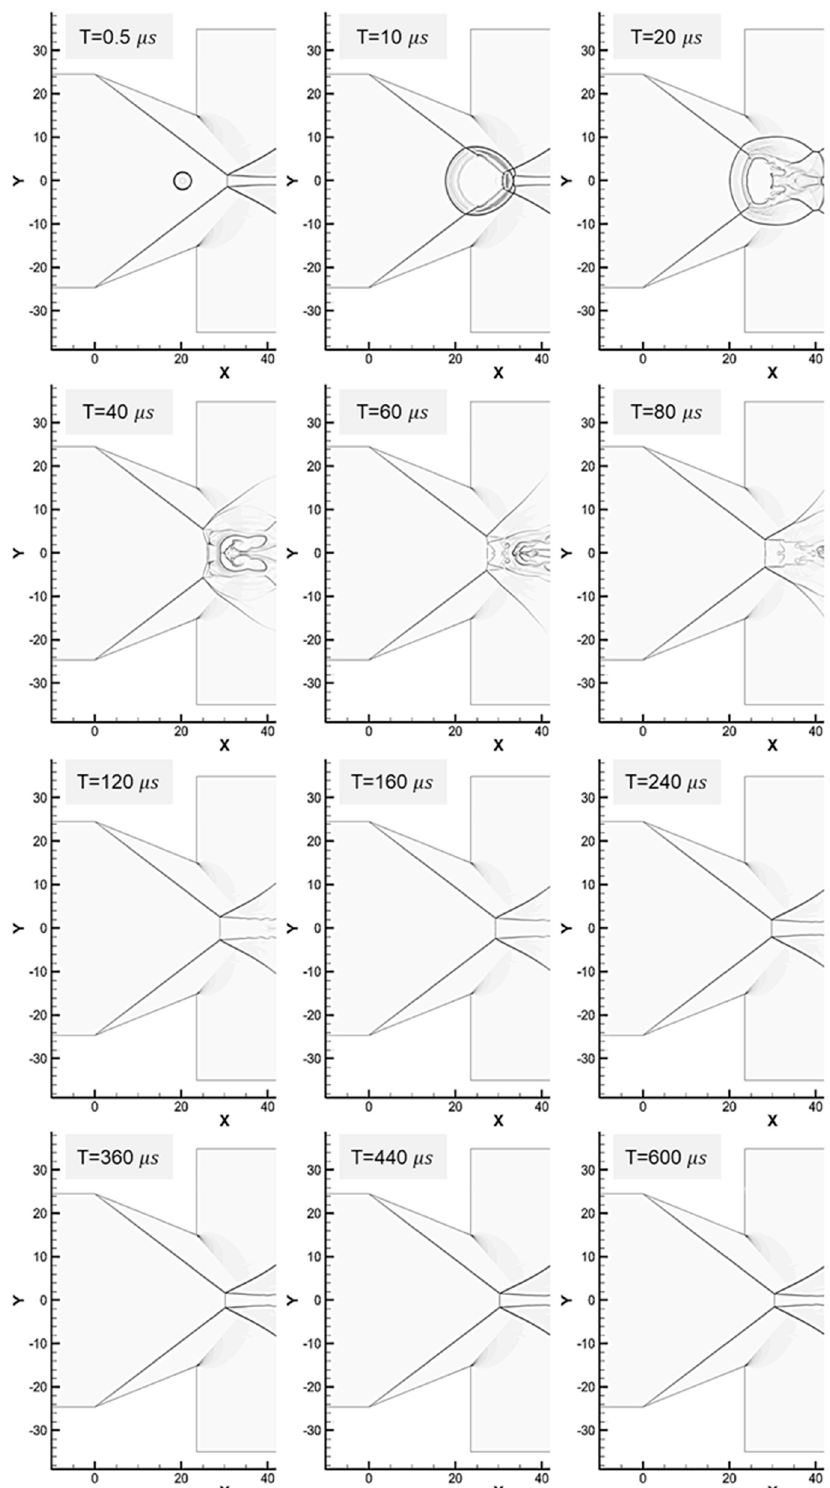
Figure 16. Interaction between blast wave and oblique shock, deposition downstream of the wedges. Energy: 215.0 mJ.